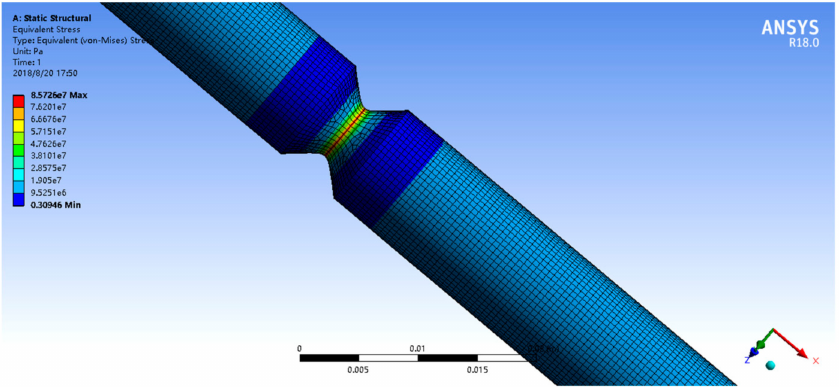
Figure 3. Shape and dimensions of the notch specimens (units: mm).